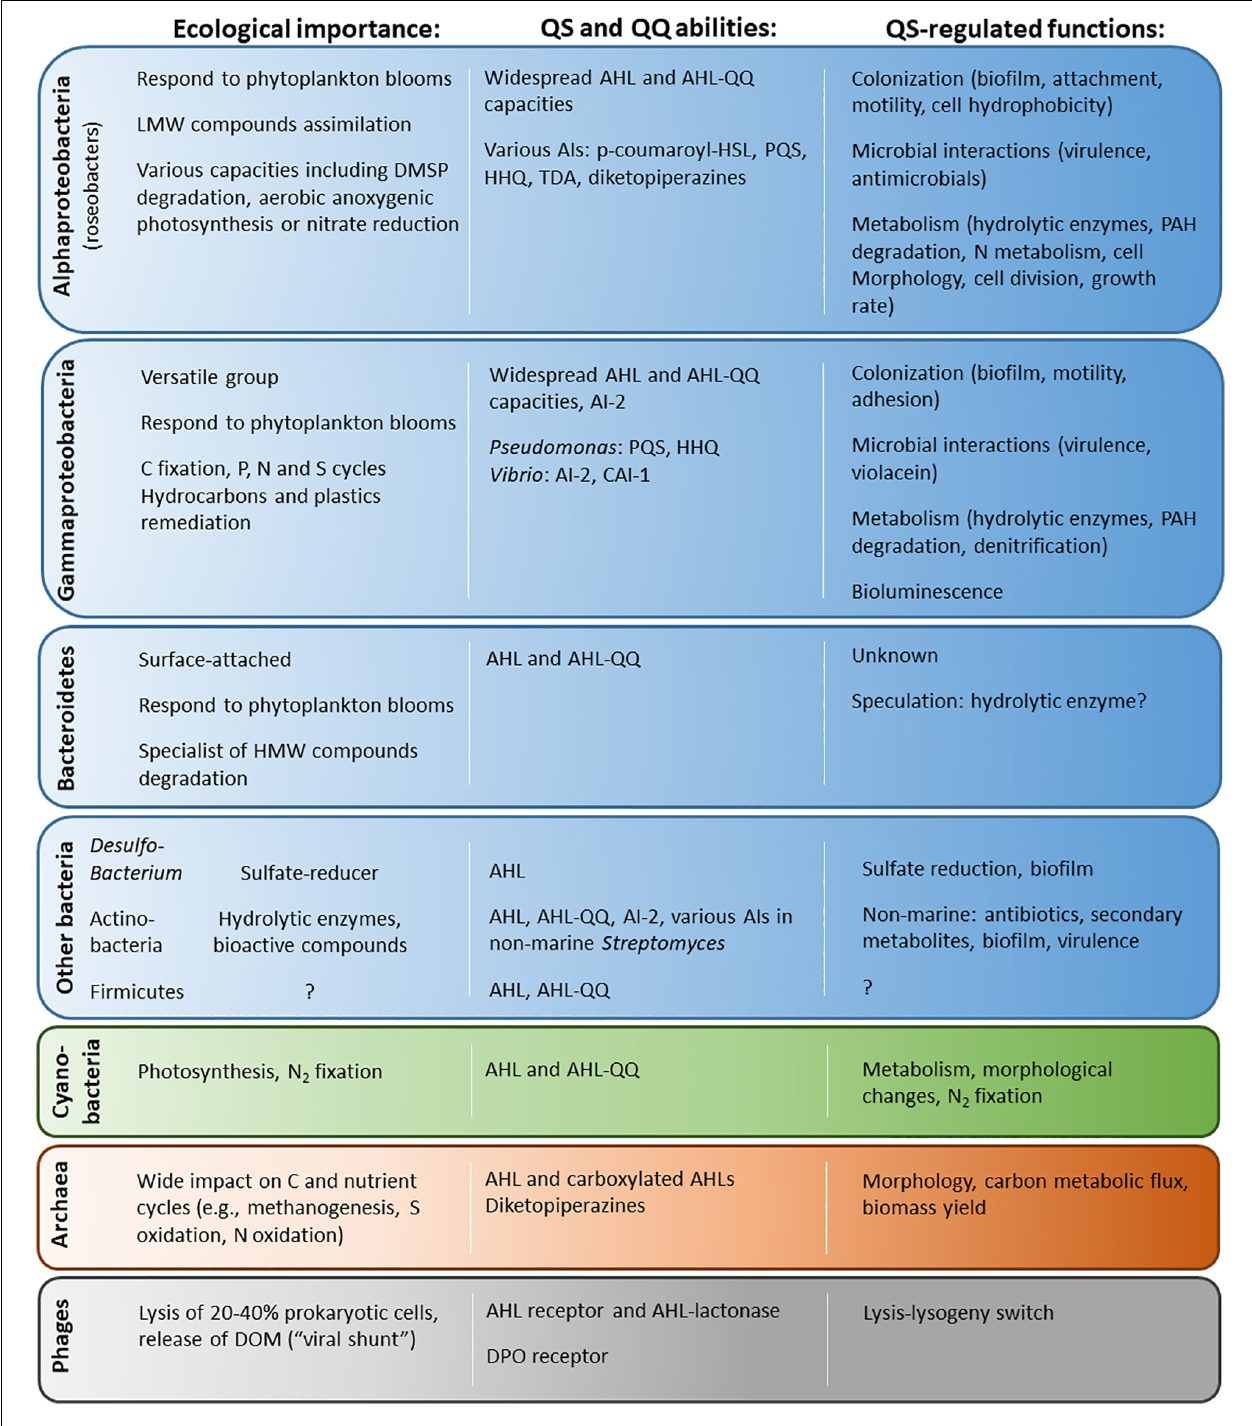
FIGURE 2 | Ecological importance, QS pathways and QS-regulated functions in the main prokaryotic groups (as well as phages) presented in this review. The relevant references can be found in the main text as well as in Supplementary Table 4 concerning QS circuits.